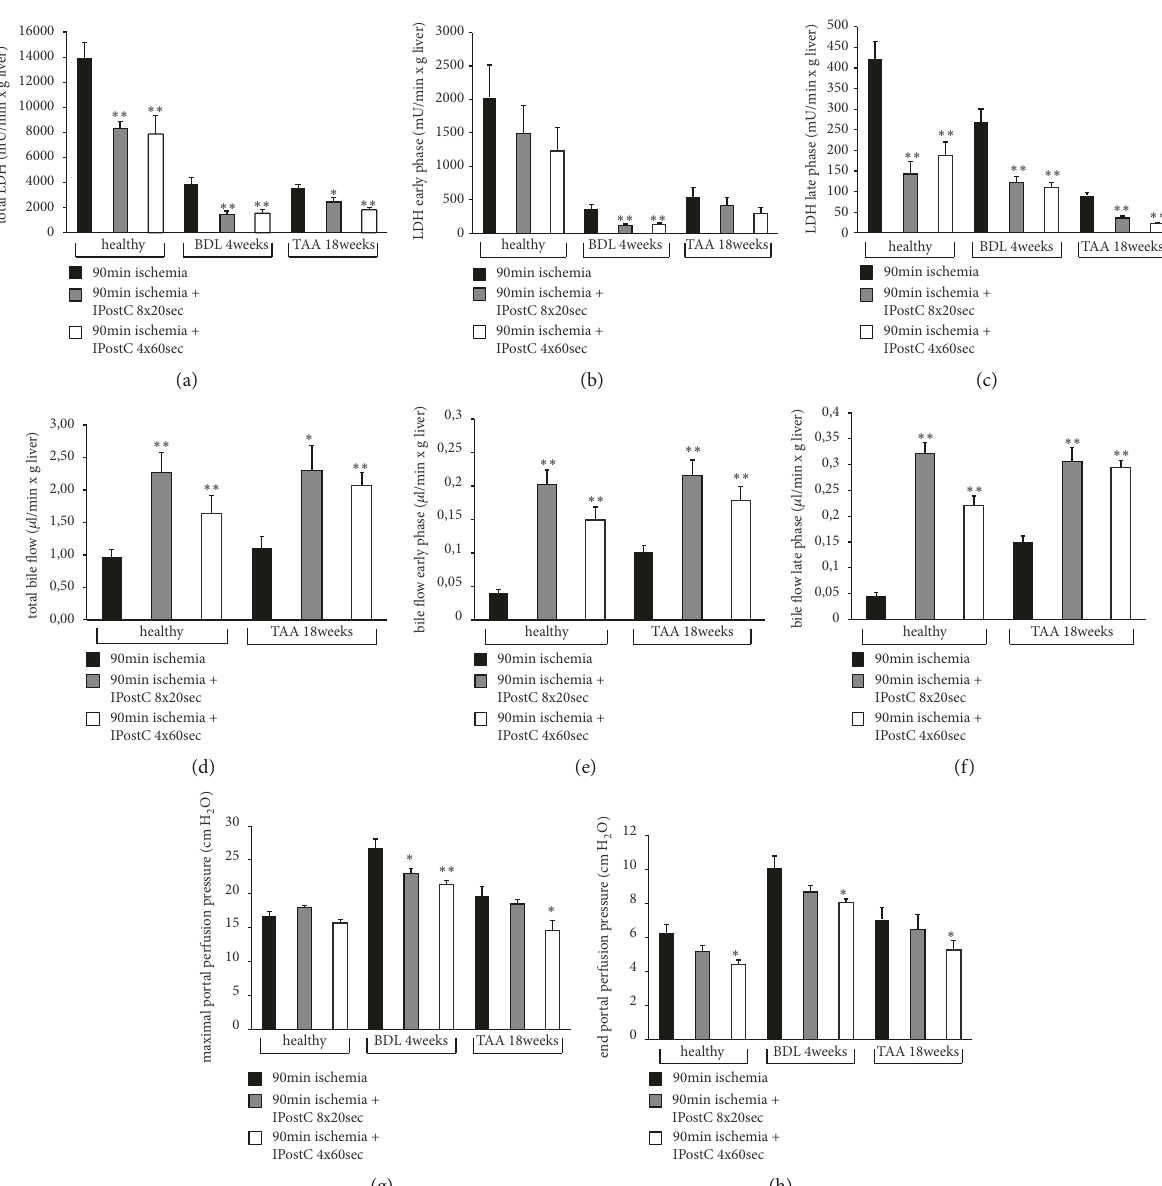
Figure 4: Lactate dehydrogenase, bile flow, and portal perfusion pressure in healthy, fibrotic, and cirrhotic livers after warm ischemia ± IPostC . Liver fibrosis was induced in male SD rats using bile duct ligation (BDL) over 4 weeks. Liver cirrhosis was induced using thioacetamide (TAA) administered via drinking water over 18 weeks. The healthy, fibrotic, and cirrhotic livers were perfused for 30 min, followed by 90 min of ischemia at 37 ∘ C and 90 min of reperfusion. The IPostC intervention groups included 8x20 sec and 4x60 sec cycles that were performed after ischemia (control and intervention groups, each n=8). Lactate dehydrogenase (LDH) was measured in the perfusate and is represented as total value (a) and during the early phase (minute 0 to 40; (b)) and the late phase (minute 50 to 90; (c)) of reperfusion. Bile was collected and also the bile flow is shown as total value (d) and at the early (e) and late (f) phase of reperfusion. For the portal perfusion pressure, which was monitored continuously, the maximum (g) and the value at the end of perfusion (h) are displayed. All data are expressed as the mean ± SEM, and significant values are specified as ∗ p < 0.05 and ∗∗ p <